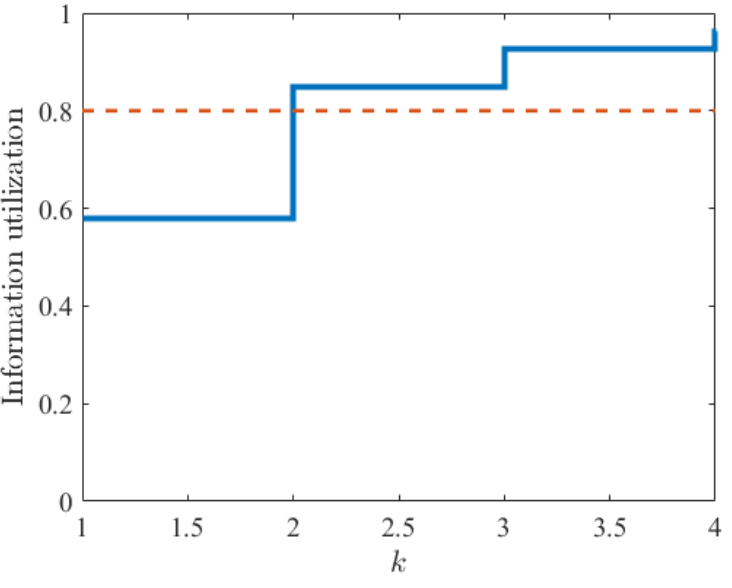
Figure 7. Texture feature utilization.